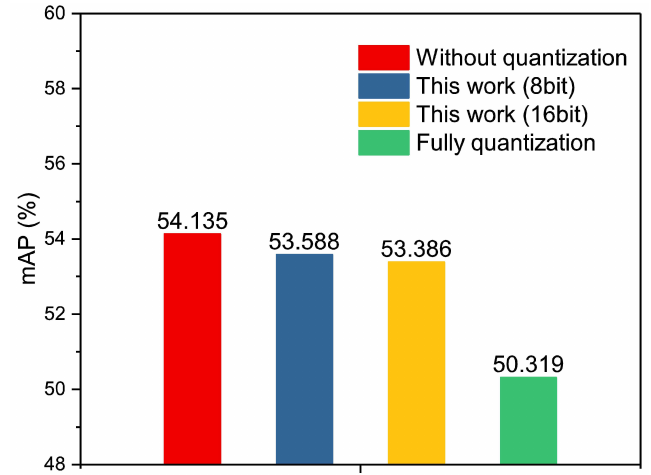
Figure 11. Comparison of the accuracy of the proposed RRAM PIM among different quantization